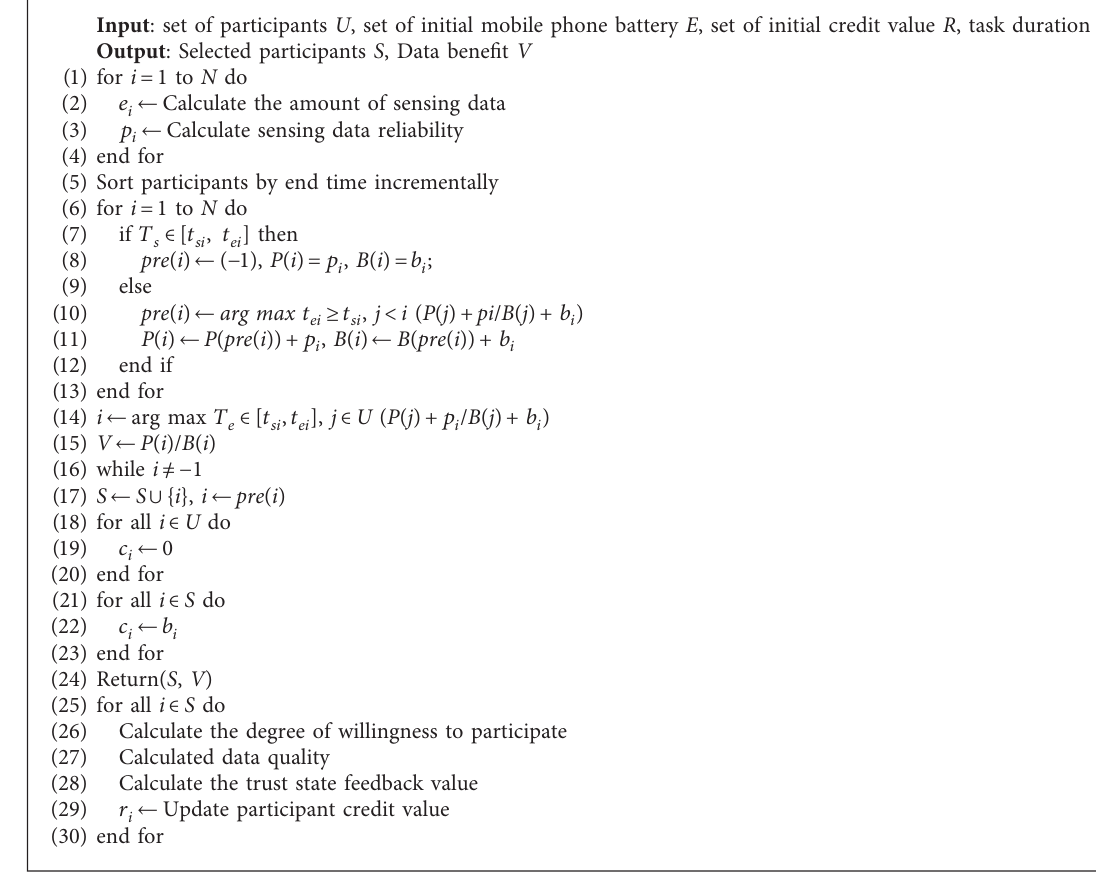
A LGORITHM 2: PS-TWDT participant selection